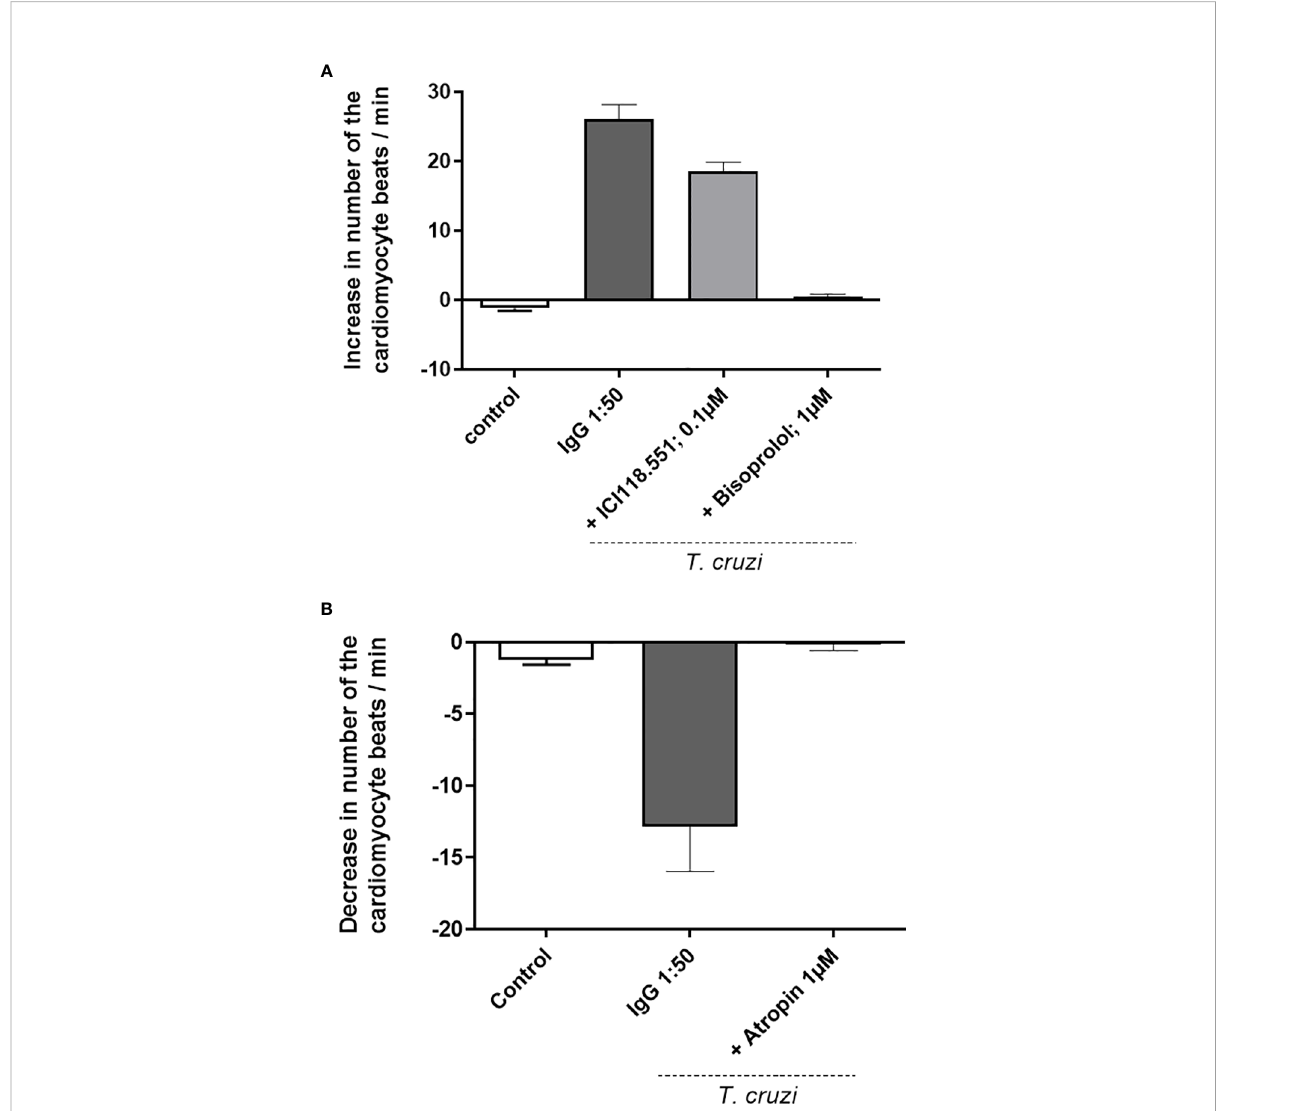
blocked by speci fi c antagonists of the b 2-adrenergic receptor (AR) (ICI118.551) and antagonist of the b 1-AR (bisoprolol). The IgG of uninfected control animals exert no effect. (B) IgG preparation from dogs infected by Y-strain under blockade of the b 1-AR and b 2-AR by bisoprolol